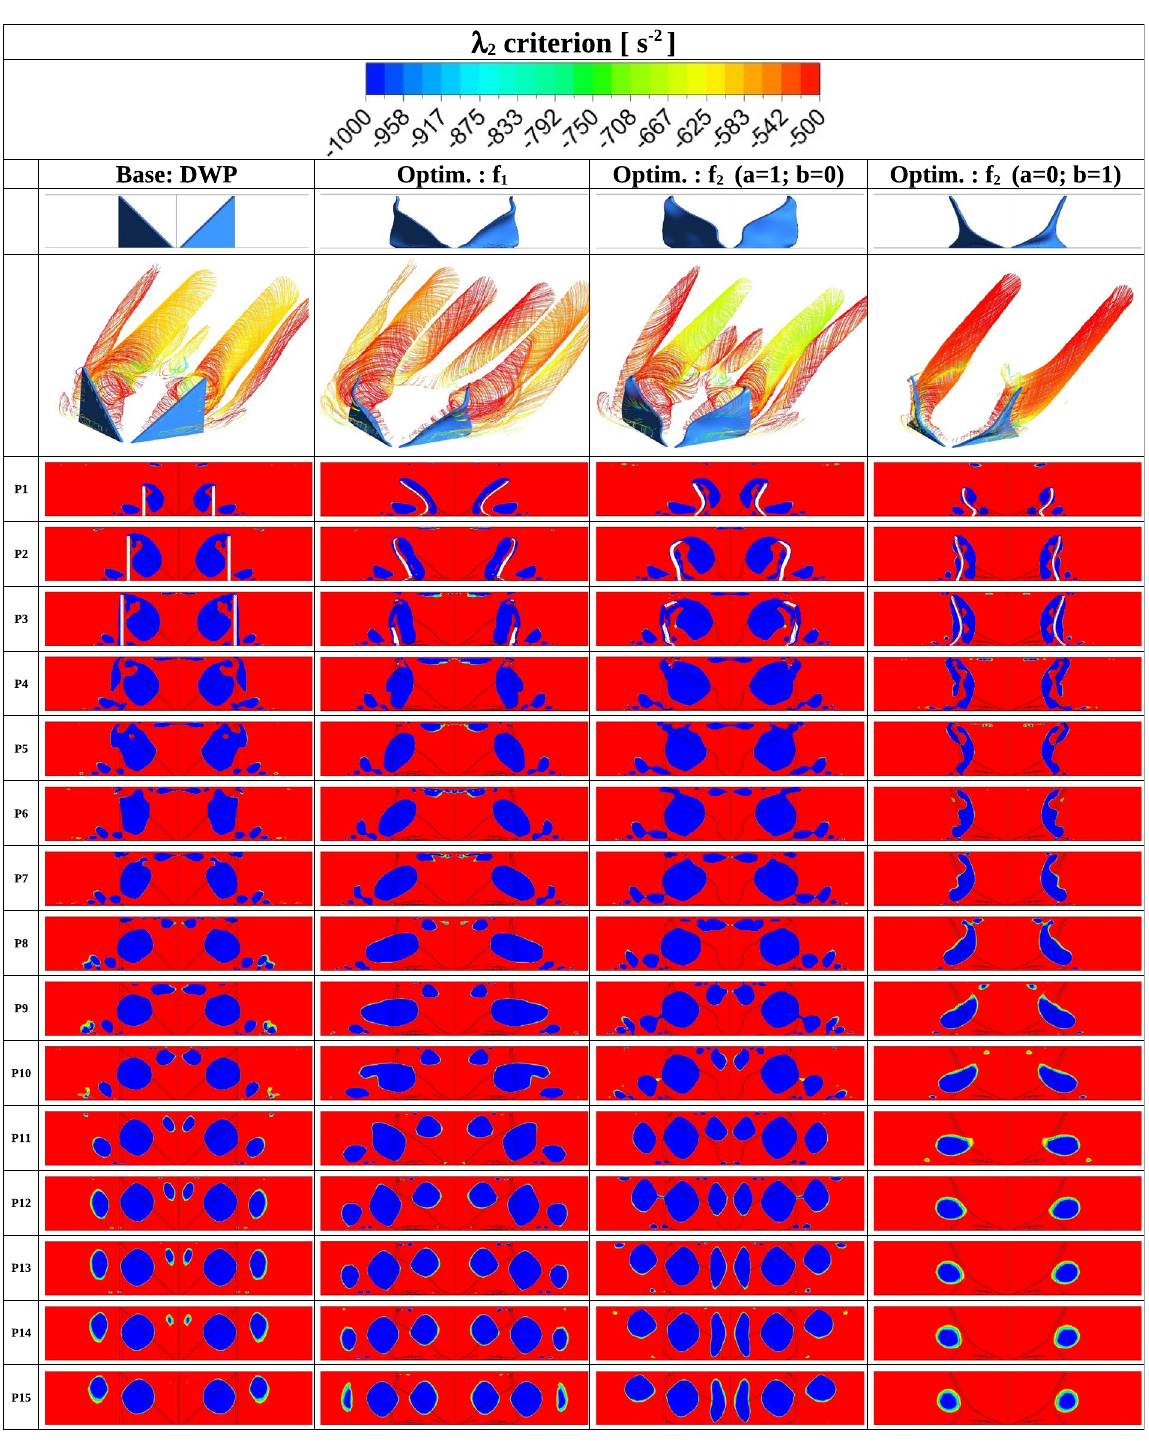
Figure 6. (cid:31) 2 criterion fields for: Base DWP design, Optimum design using f 1 (Eqs. 4, 9), Optimum design using f 2 with a = 1 and b = 0 (Eq. 5) and Optimum design using f 2 with a = 0 and b = 1 (Eq.